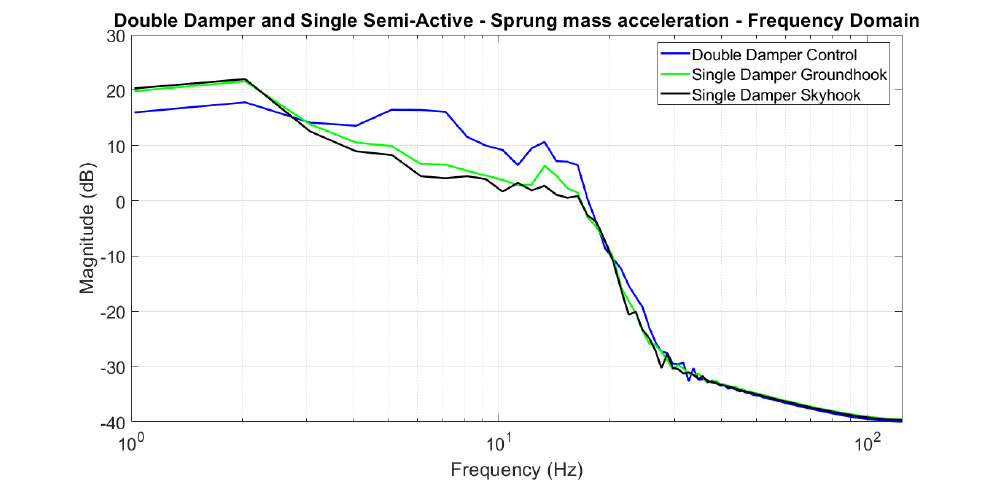
Figure 11. Frequency Domain sprung mass acceleration plot for semi-active single and double damper.